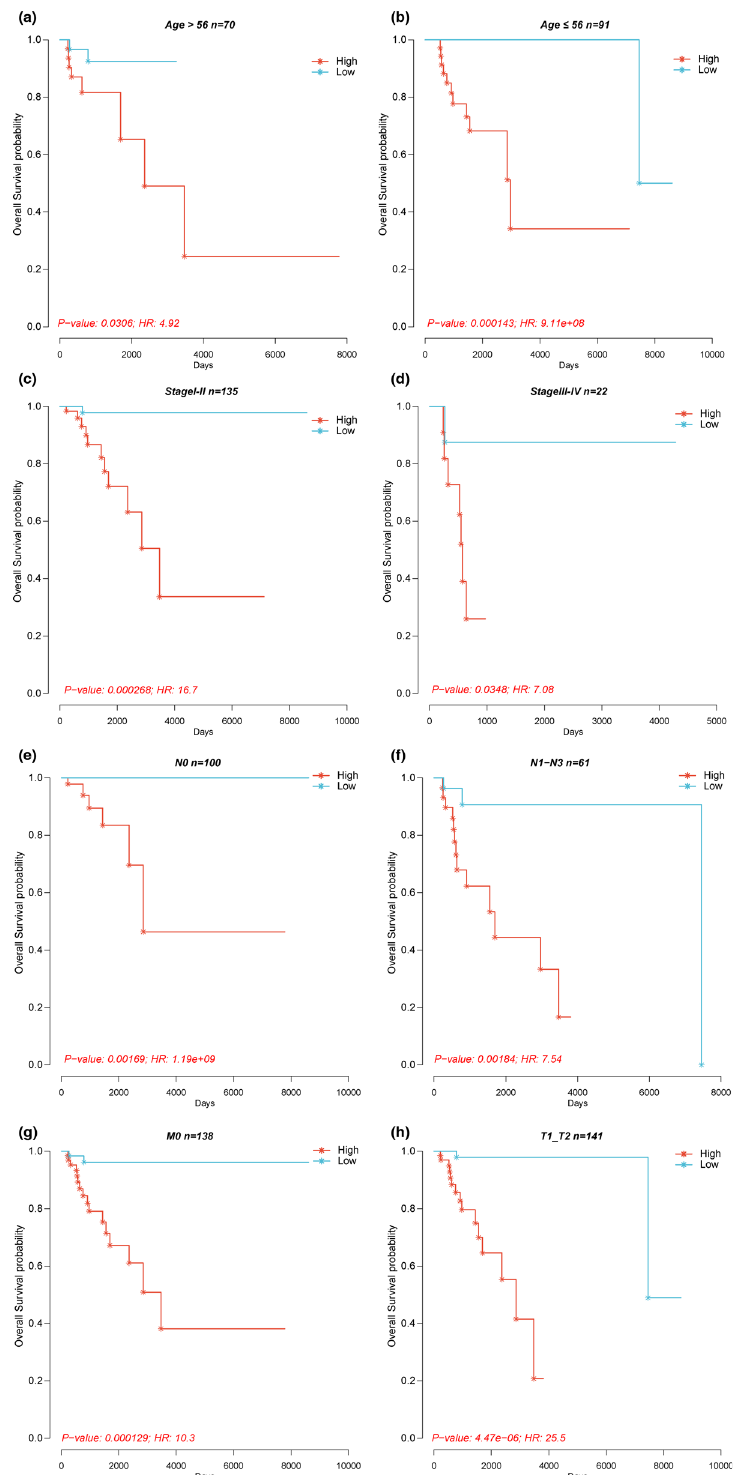
Figure 3: Kaplan – Meier survival analysis between the high - risk and low - risk groups in patients in the group of patients ’ age older than 56 years ( a ) , the group of patients ’ age younger than 56 years ( b ) , the group of patients with stages I – II ( c ) , the group of patients with stages III – IV ( d ) , the group of patients with N0 ( e ) , the group of patients with N1 – N3 ( f ) , the group of patients with M0 ( g ) , and the group of patients with T1 – T2 ( h )